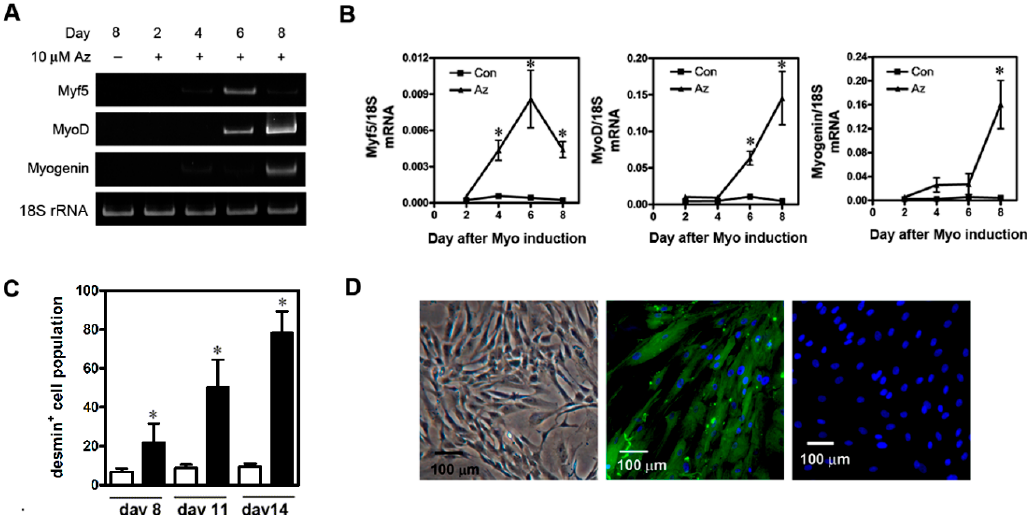
Figure 2. In vitro di ff erentiation of uMSCs into myoblast-like cells. The uMSCs were treated with 10 µ M 5-azacytidine and then cultured for two, four, six, or eight days in myogenic inductive medium, after which the expression of the myogenic-lineage genes for myogenic factor 5 (Myf5), myogenic determination factor (MyoD), and myogenin was determined by ( A ) RT-PCR and ( B ) quantitative PCR. Cells cultured in Dulbecco’s Modified Eagle Medium (DMEM) (high glucose) supplemented with 20% Fetal Bovine Serum (FBS) served as negative controls. Data are shown as means ± standard deviation (SD) of six independent experiments using di ff erent batches of cells and were analyzed by ANOVA with repeated measurement. ( C ) The percentage of desmin + cells present on days eight, 11, and 14 after uMSCs were myoinduced to di ff erentiate in vitro. To quantify the number of desmin + cells present, the cells were firstly stained with an anti-desmin antibody and an isotype-matched Fluorescein isothiocyanate (FITC)-Immunoglobulin (Ig)G, and then quantified using flow cytometry. The data for each time point were obtained from four independent experiments, reported as means ± SD. ( D ) Representative images of uMSCs grown in vitro before and after myoinduction. Left panel: undi ff erentiated uMSCs had a spindle-like appearance. Middle panel: desmin + cells 14 days after myoinduction that were identified using an anti-desmin antibody as described above. Right panel: negative controls that did not include the anti-desmin antibody. Scale bar, 100 µ m; * p < 0.05 for induced vs. uninduced